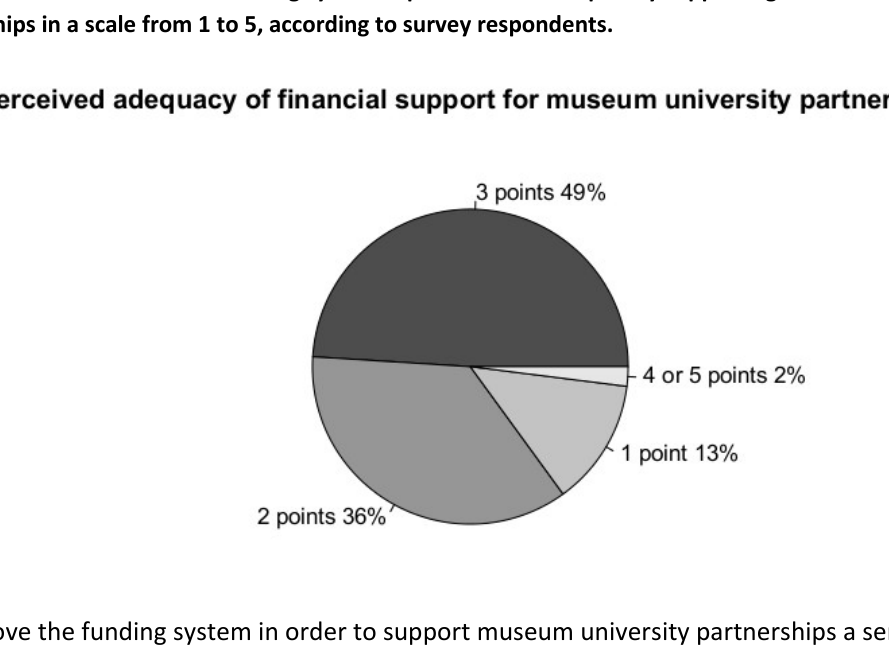
Figure 11. Extent to which the funding system is perceived as adequately supporting museum university partnerships in a scale from 1 to 5, according to survey